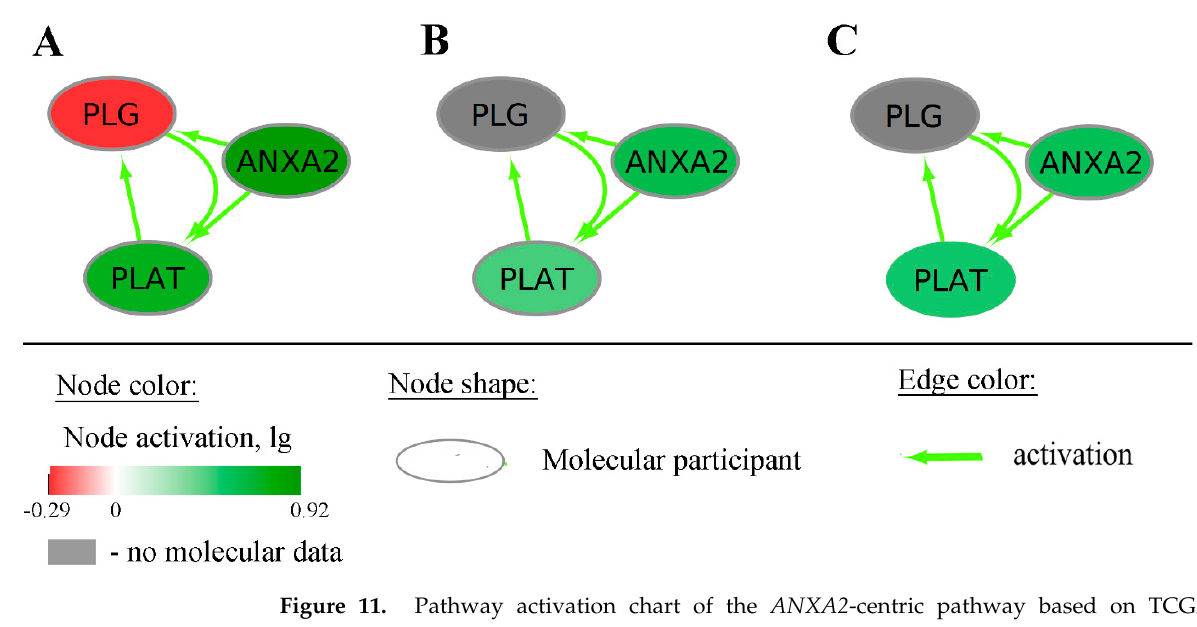
Figure 11. Pathway activation chart of the ANXA2 -centric pathway based on TCGA ( A ), CGGA_325 ( B ), and CGGA_693 ( C ) datasets. Node activation was calculated as a logarithmic ratio of the geometric mean of expression levels in GBM patients to the geometric mean of expression levels in LGG patients. Table 2. Statistics of gene and pathway expression biomarkers distinguishing GBM molecular subtypes.